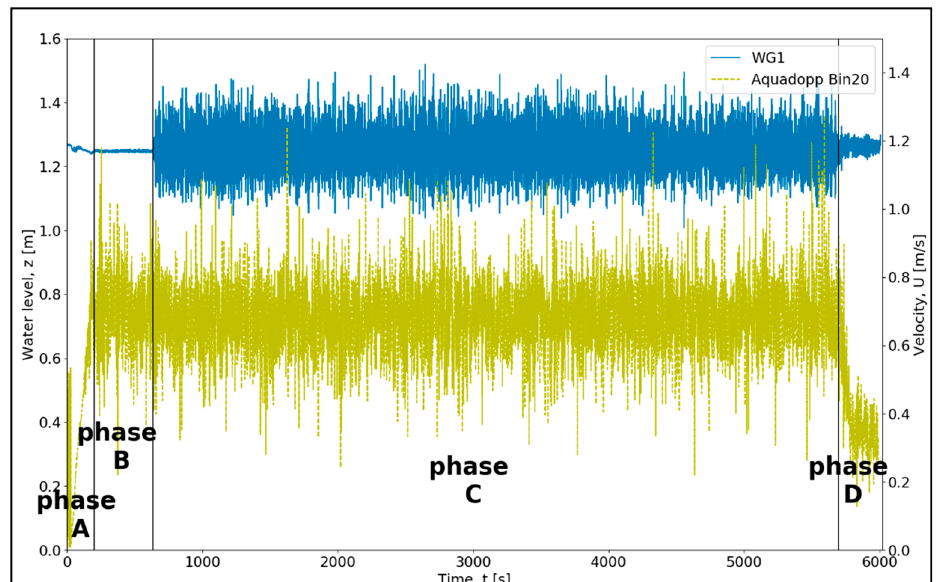
Figure 12. Test 04_B measurement of WG1 (left vertical axis) and Aquadopp at bin 20 (right vertical axis) with test phases: (“phase A”) Initialization of the test (time: 0–200 s); (“phase B”) Current stabilization (time: 200–633 s); (“phase C”) Wave Generation (time: 633–5697 s); (“phase D”) Test finalization and water level stabilization (time: 5691–6010 s).